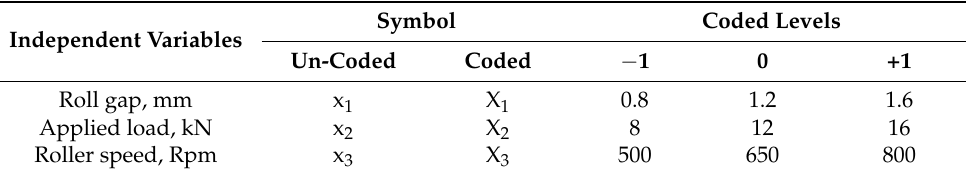
Table 1. Actual and coded values of the operating